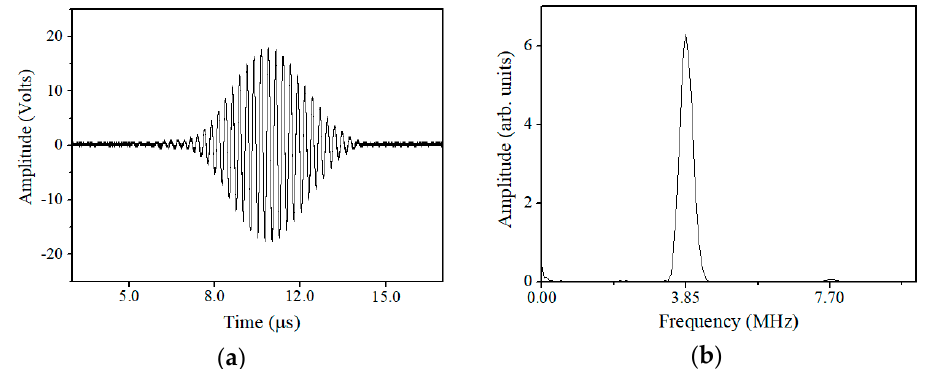
Figure 5. Typical excited ultrasonic signals in ( a ) time domain and ( b ) frequency spectra of the original signals.